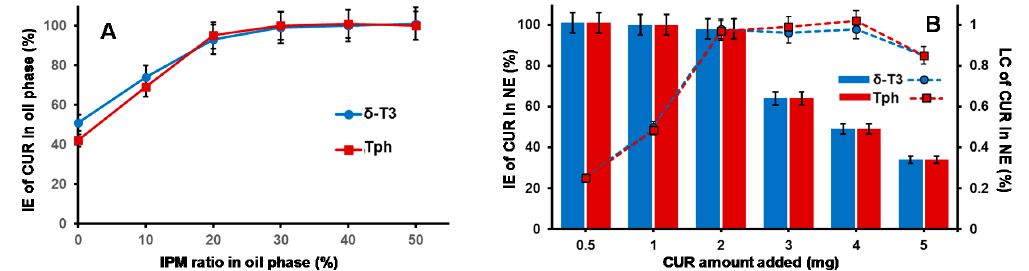
Figure 2. Curcumin incorporation capacity and loading capacity profiles demonstrated for ( A ) δ -tocotrienol oil phase blended with isopropyl myristate; and ( B ) nanoemulsion formulations in respect to amounts of feed curcumin added during preparation ( n = 3, mean ± SD).